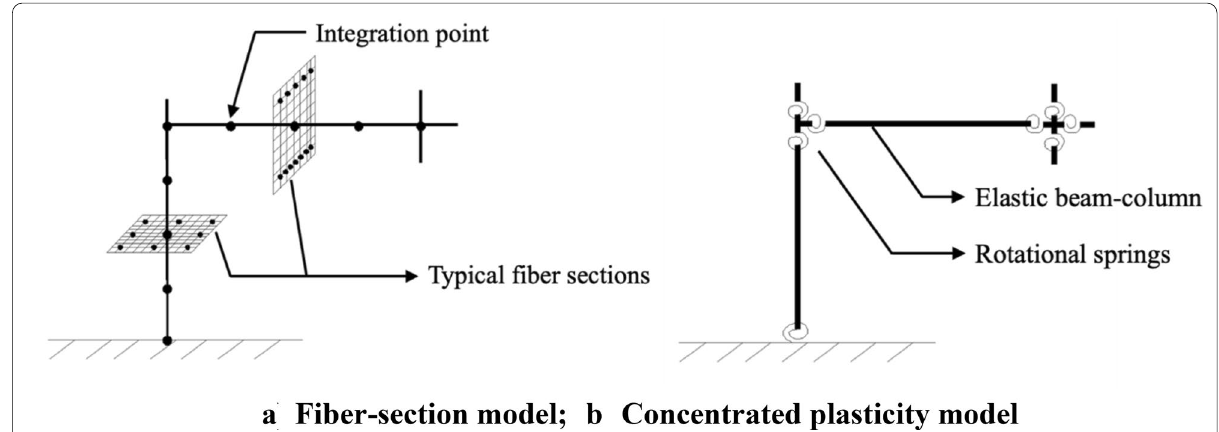
Fig. 2 Element modeling options. a Fiber-section model. b Concentrated plasticity model.